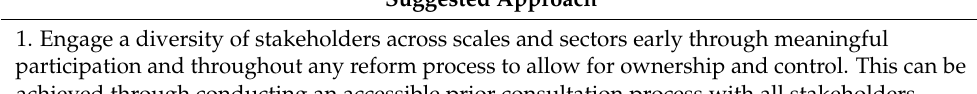
Table 2. Suggested approaches to an inclusive and participatory forest governance reform, after Chazdon, et al. [12], Henao, et al. [25], Wilson and Cagalanan [78]. Suggested